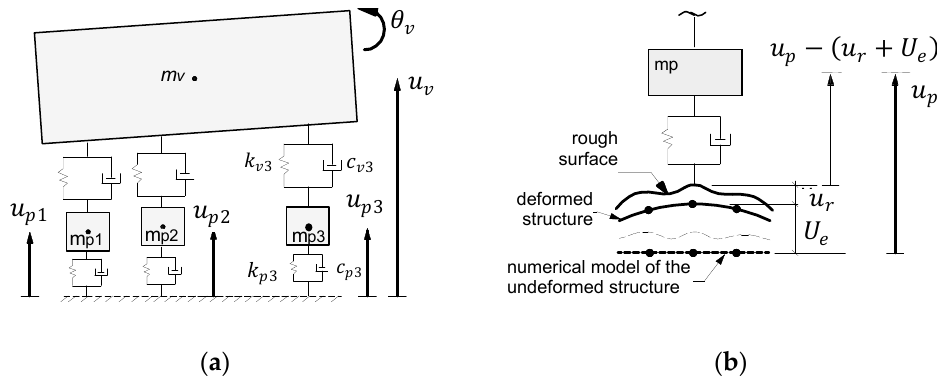
Figure 6. ( a ) Analytical model of the rigid three-axle vehicle (class 3C). ( b ) Axle-structure contact point displacements.